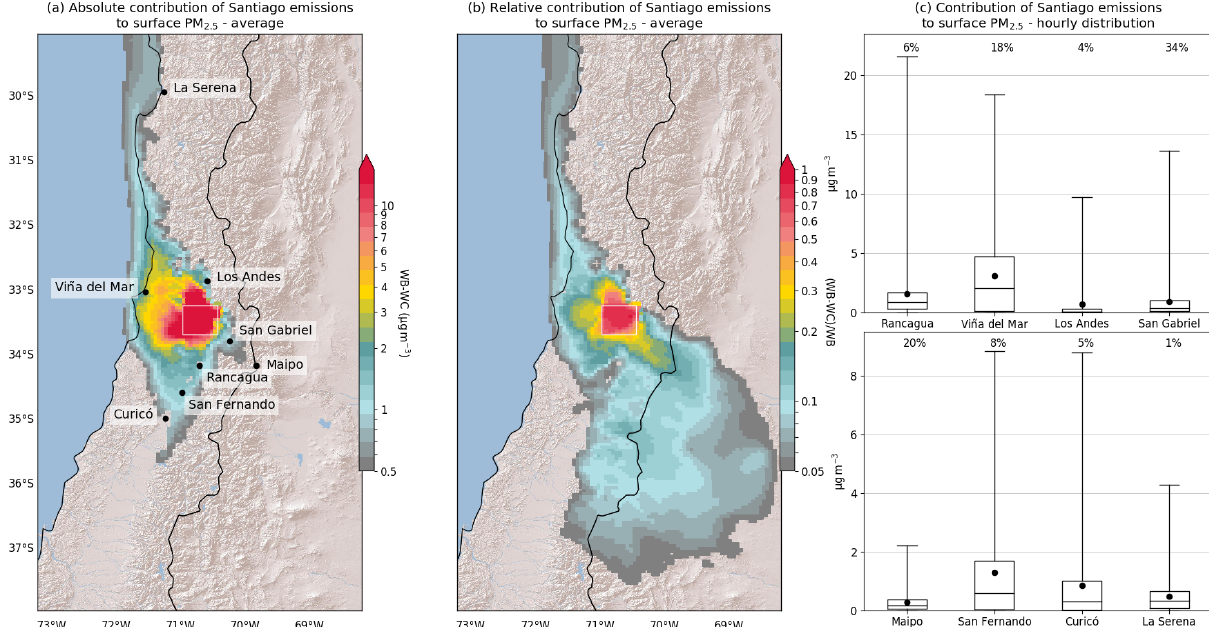
Figure 4. (a) Average ground-level PM 2 . 5 concentration difference between WB (winter baseline case) and WC (winter contribution case) yielding the Santiago emissions contribution. Concentrations in excess of 0.5µgm − 3 are displayed. The white box shows the area in which emissions are set to zero in WC. Panel (b) is the same as (a) in terms of the relative contribution, i.e., (WB-WC)/WB. Contributions in excess of 5% are displayed. (c) Distribution of Santiago emissions contribution to hourly PM 2 . 5 concentration at several sites across central Chile; horizontal lines are quartiles, whiskers show minimum and maximum, and the dots are the means. All figures are based on hourly concentrations and are for wintertime 2015. In panels (a) and (b) , only grid points at which the distribution of concentrations in scenario WC is different than in scenario WB at the 90% level, based on a t test, are shown. Map background layer source: World Shaded Relief, ©2009